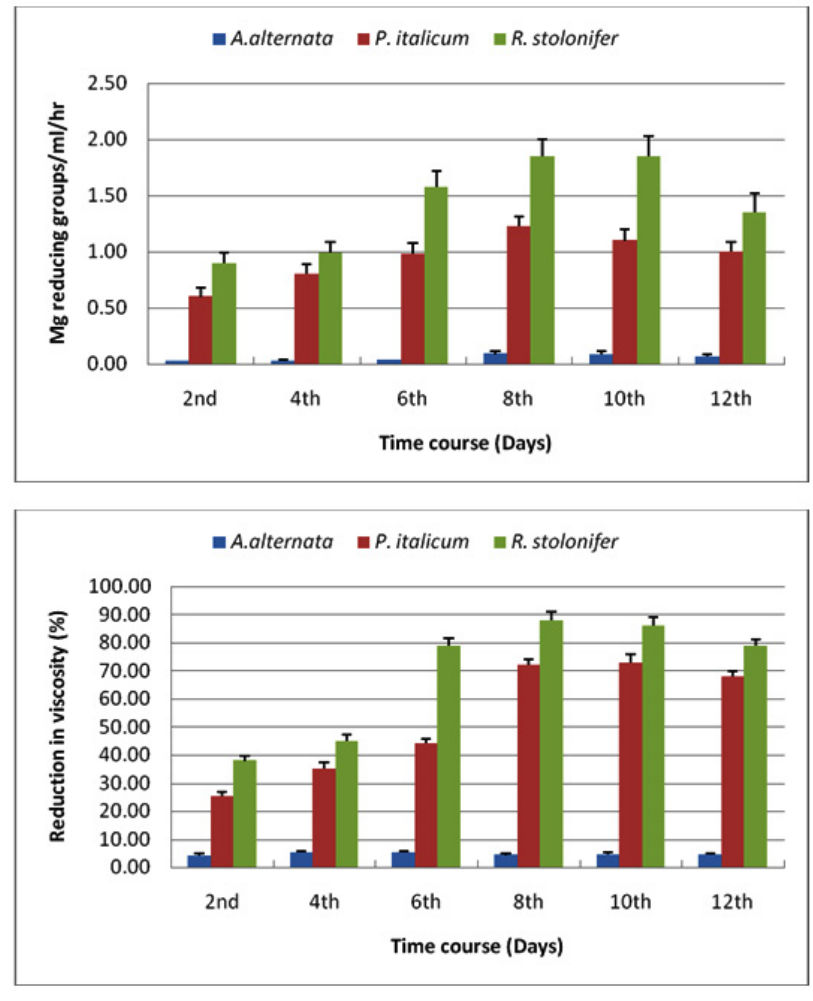
Fig. 1. Time course of CMC-ase using Czapek Dox medium amended with cellulose as carbon source for A. alternata , P. italicum and R. stolonifer at 28 ºC in the dark. All the data are the mean of three replications and Bar on each column represents the standard